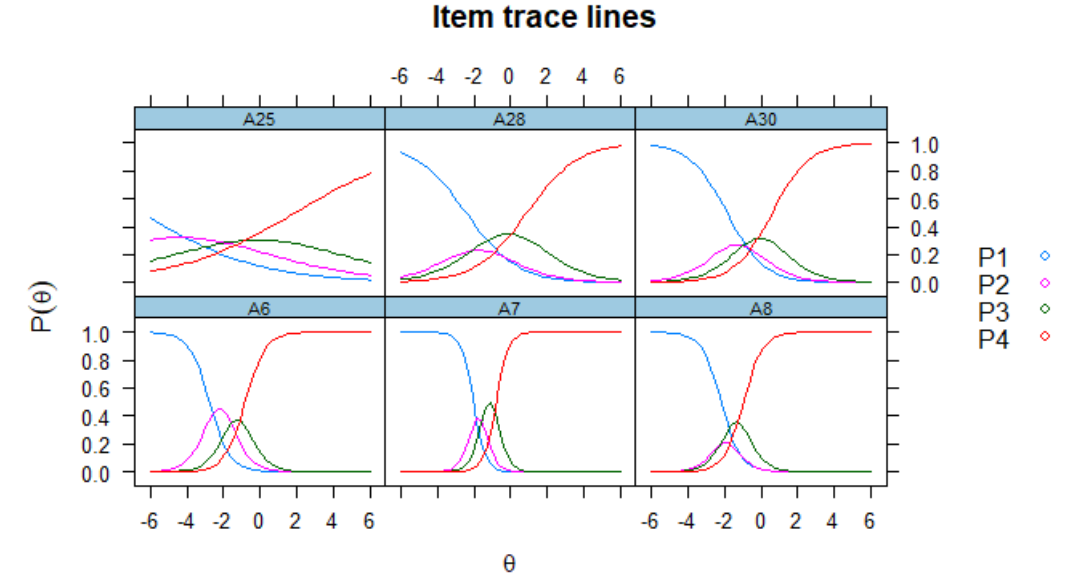
Figure 4. ICCs of the Inner Peace and Family Support Needs component.